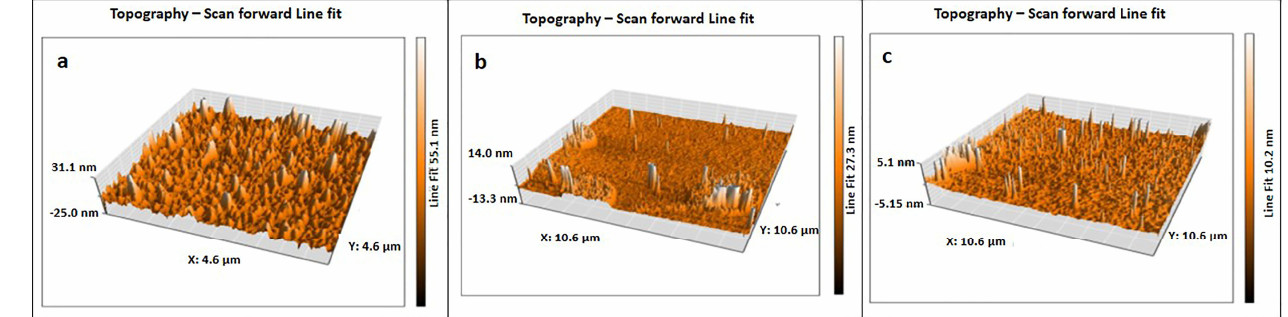
Figure 10. Morphology analysis of jute cellulose nanocrystal samples of ( a ) CN-2, ( b ) CN-4, and ( c ) CN-6 by AFM (3D) images.